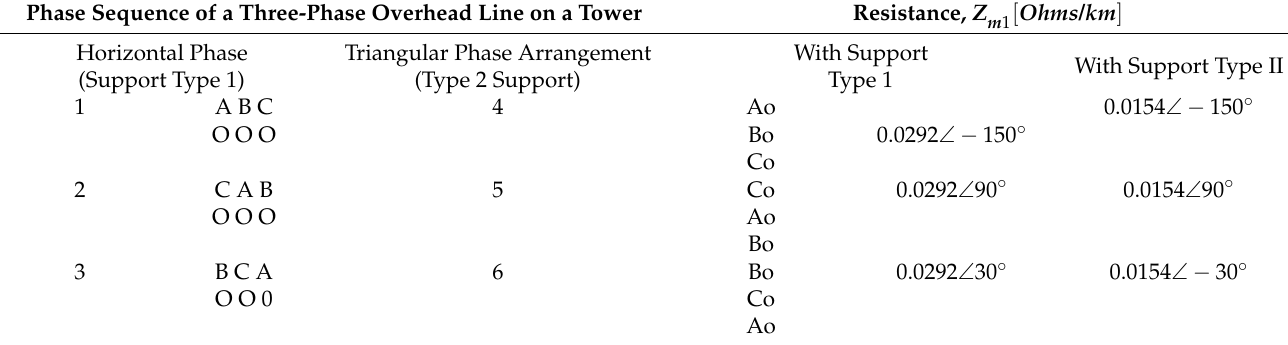
Table 1. The values of the parameters of the power transmission line depending on the phasing and the geometric arrangement of the phase wires on the tower.